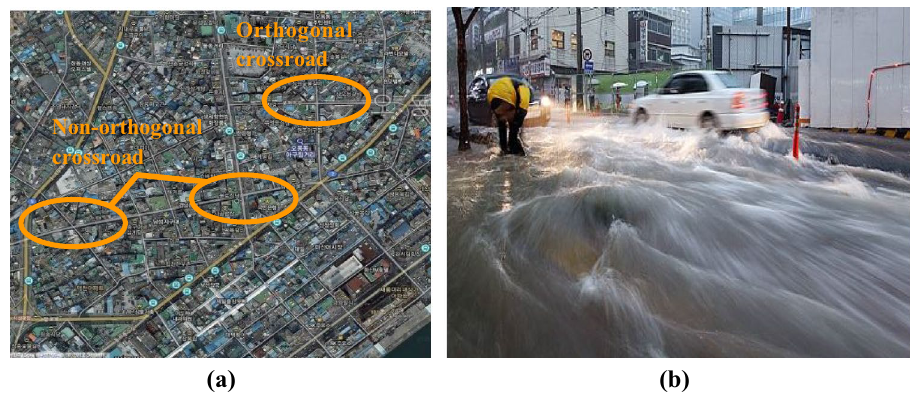
Fig. 1 a Road network in an urban area and b complex flood flow at the crossroad